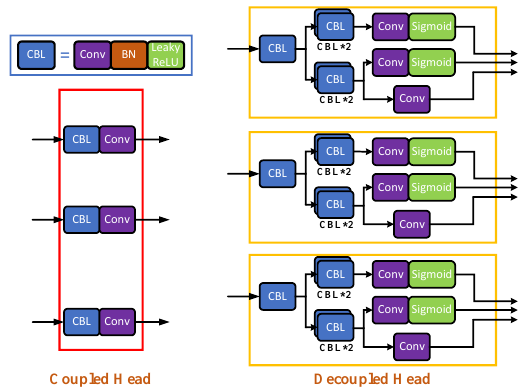
Figure 8 The Decoupled Head and coupled